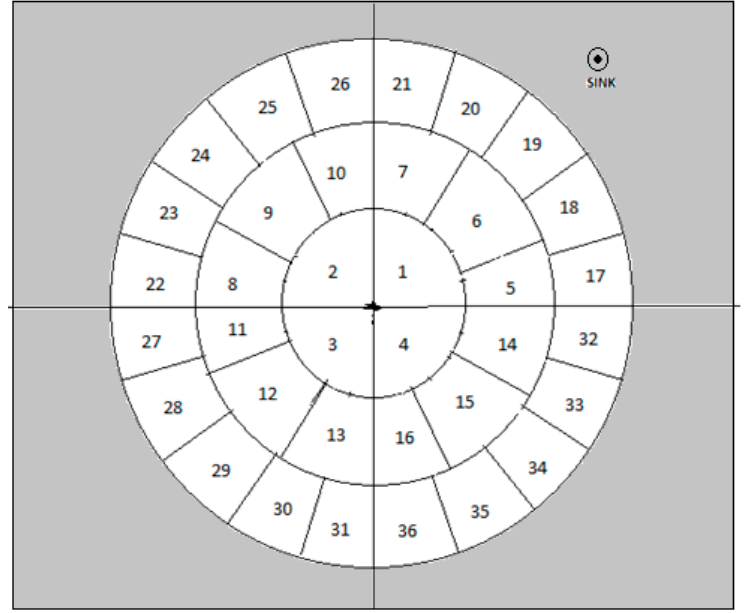
Figure 1. Deployment structure of radial-shaped clustering.